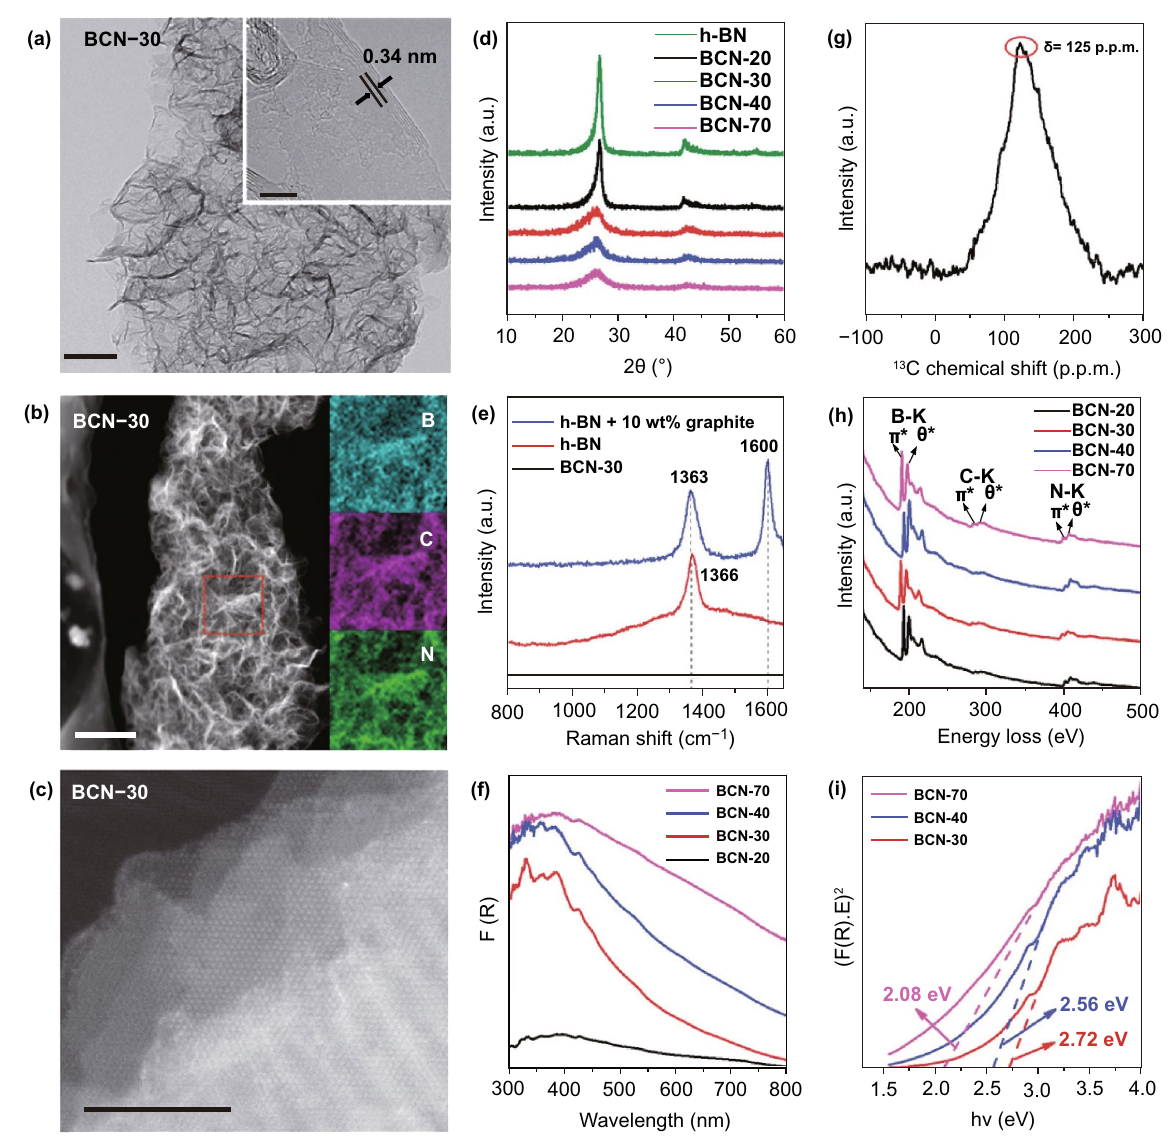
Fig. 11 a HR‑TEM of BCN‑30. b Dark‑field TEM image of BCN‑30 and element map. c HR‑STEM of the BCN‑30 sample along (002) facet. d XRD of h‑BCN. g NMR spectra of BCN‑30. e Raman spectrum of h‑BN and BCN‑30 and physical mixture of h‑BN and graphite. h EELS spectrum of BCN‑ x . f UV–Vis diffuse reflectance spectra of BCN‑ x . i BG calculation of BCN‑ x from the (F(R) E)n versus E plots. Adapted with permission from Ref.